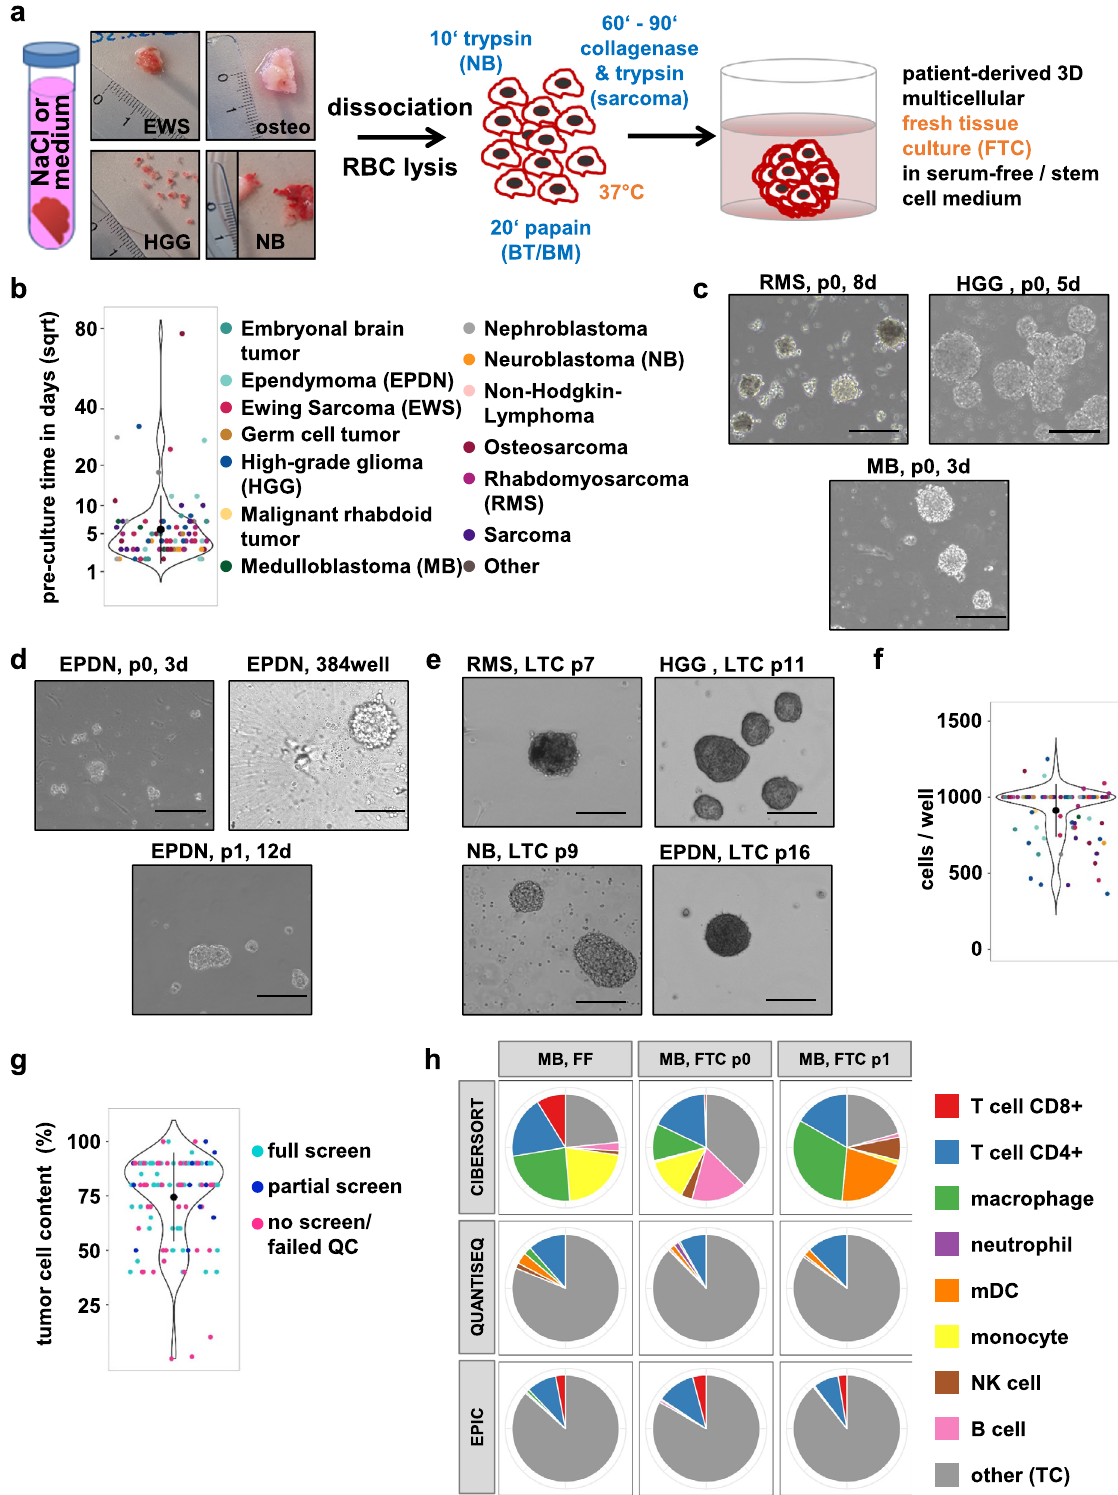
comparison of the CNA plots for the fresh frozen material from